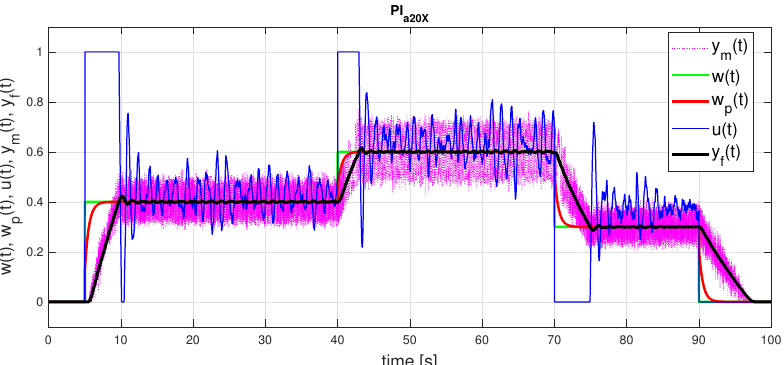
Figure 12. PI control: setpoint responses corresponding to FOTD20X approximation (50) achieved with t a = 20 for a modified grid of parameters (41) with two times finer steps for T and K s and the controller parameters